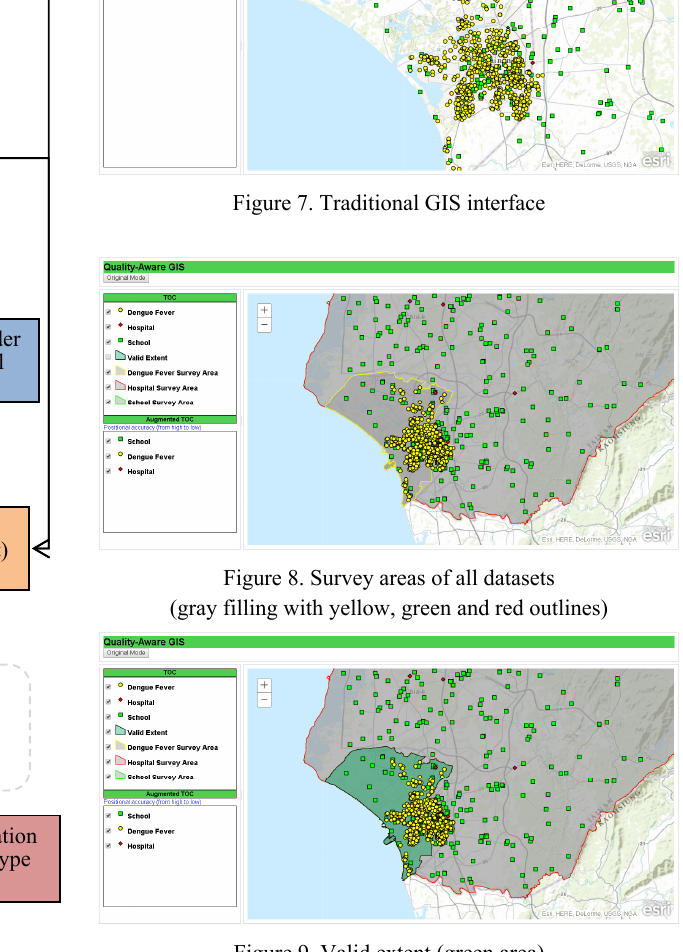
Figure 9. Valid extent (green